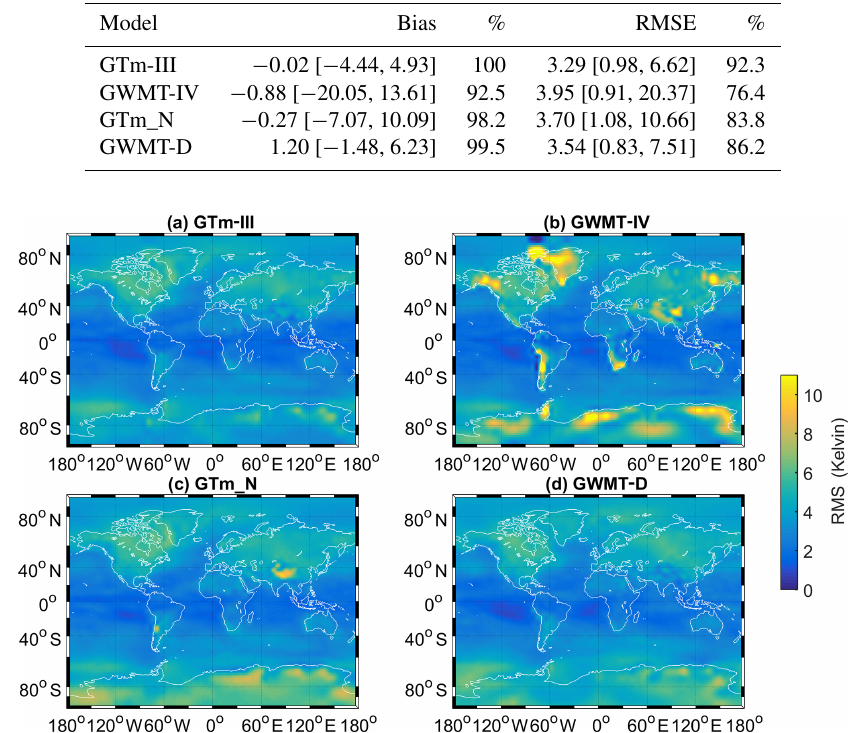
Table 4. Global statistics of the differences between the surface T m derived from four models and GGOS data in 2014 (in K).